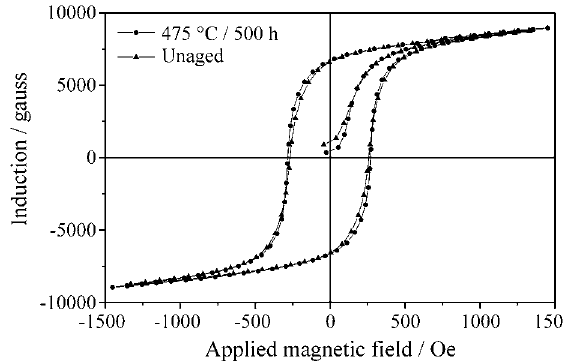
Figure 3. Comparison of the hysteresis loops of the samples solution treated and aged at 475 °C for 500 h.